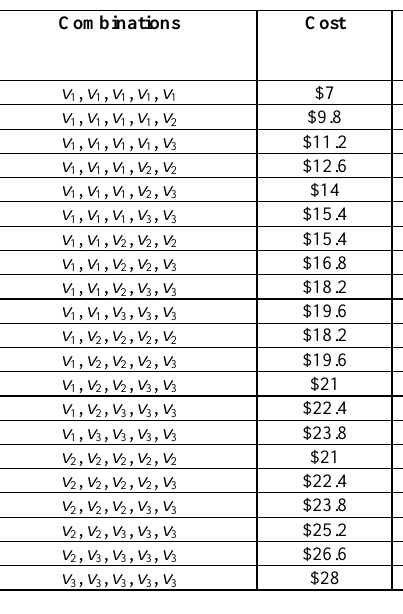
Table 4. Results of 4-out-of-5 with 3 cloud providers